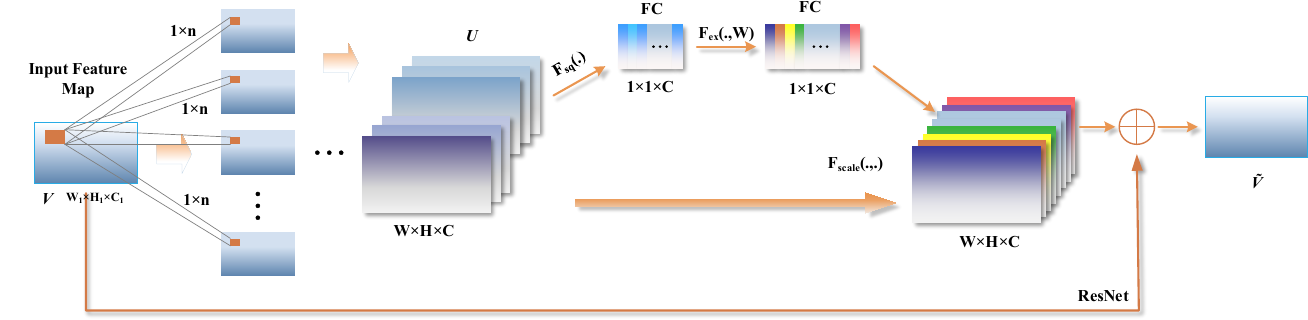
Figure 16. A structure scheme of the Channel-wise Attention based on squeeze-excitation block.